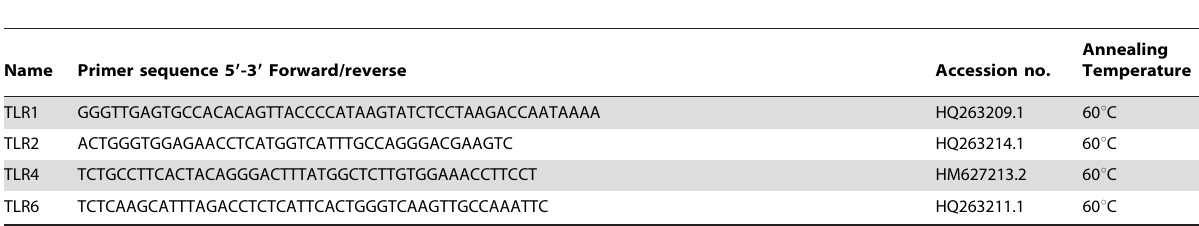
Table 2. Primer sequences for TLR1, TLR2, TLR4 and